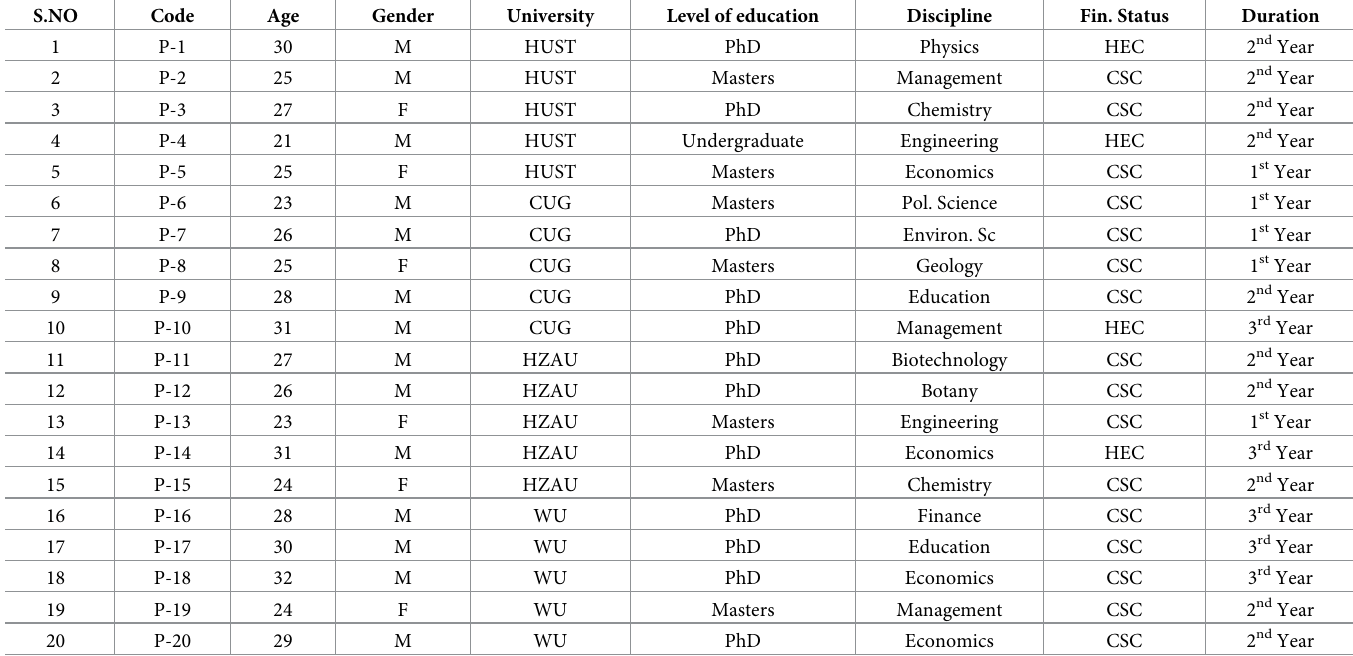
Table 2. Demographic information of interview participants.